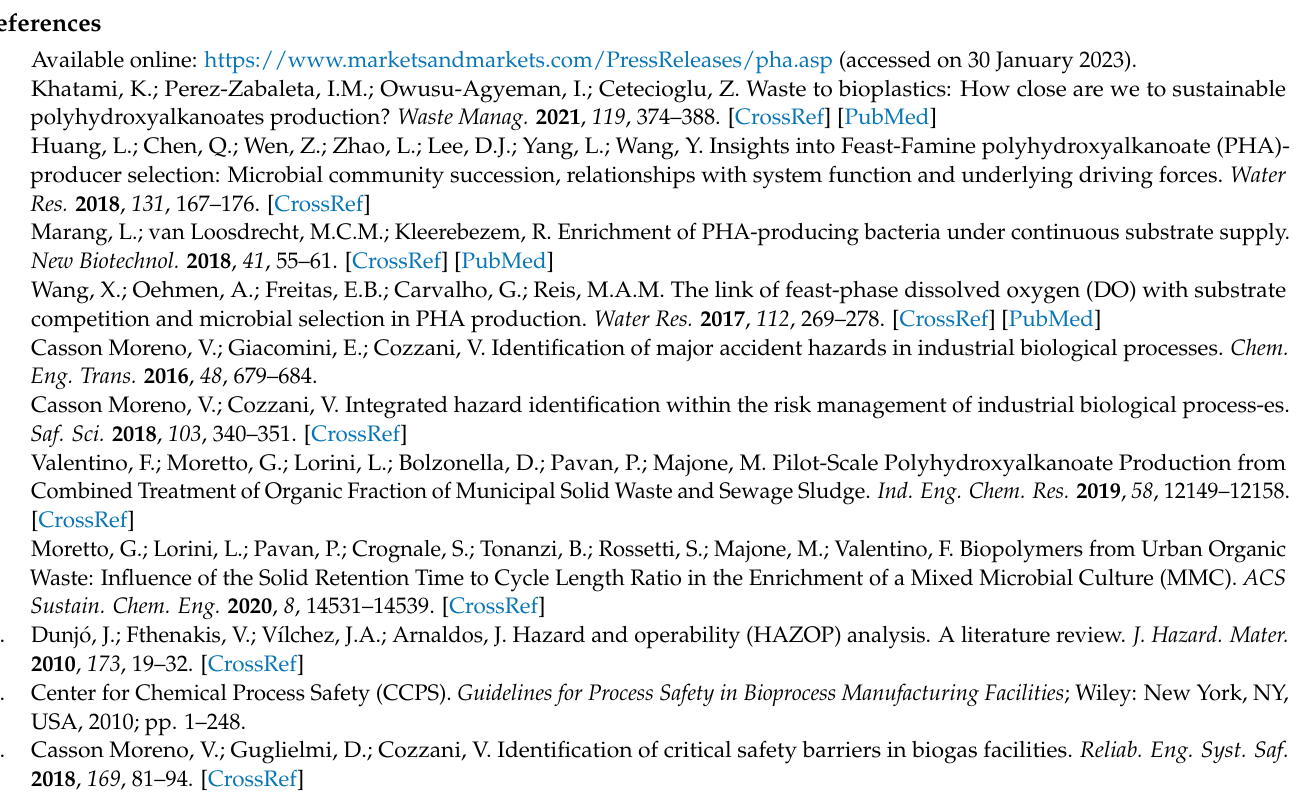
Figure A1. SBR P&ID.